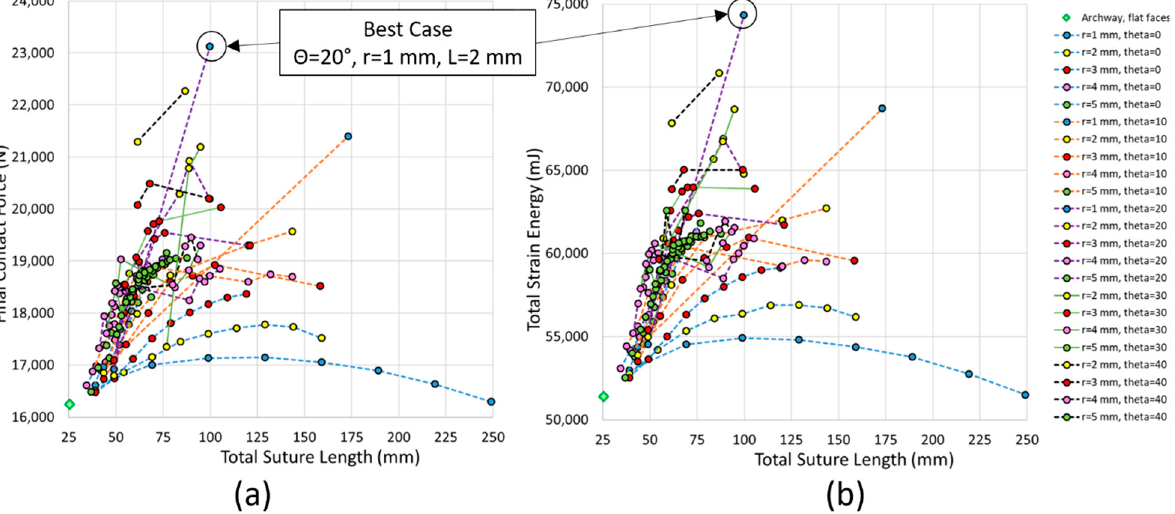
Figure 8. Total deformation (in mm) of the two base cases: ( a ) solid archway with no suture; ( b ) archway with a straight-line suture; and ( c ) one representative case with a dovetail suture. A scale factor of 3 was used to exaggerate the deformed shape. The maximum deformation in ( b , c ) exceeded the applied indenter displacement of 6.5 mm.